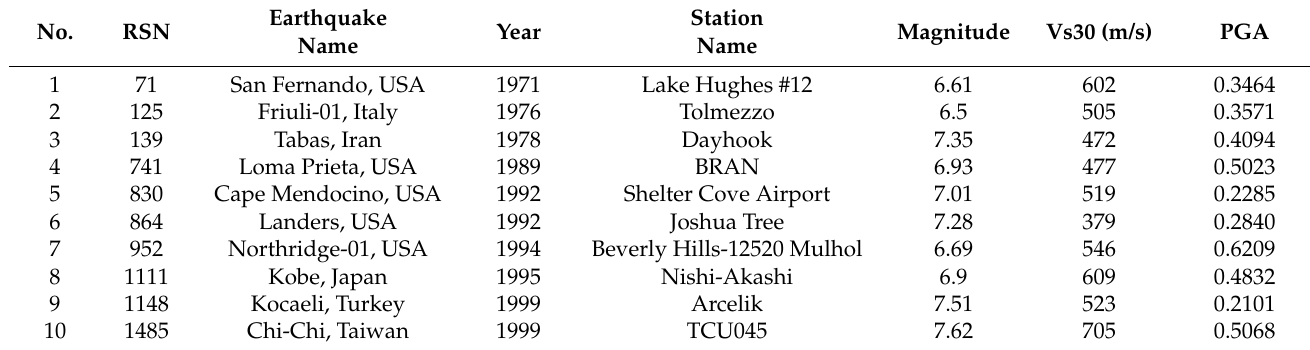
Table 1. Selected ground motion